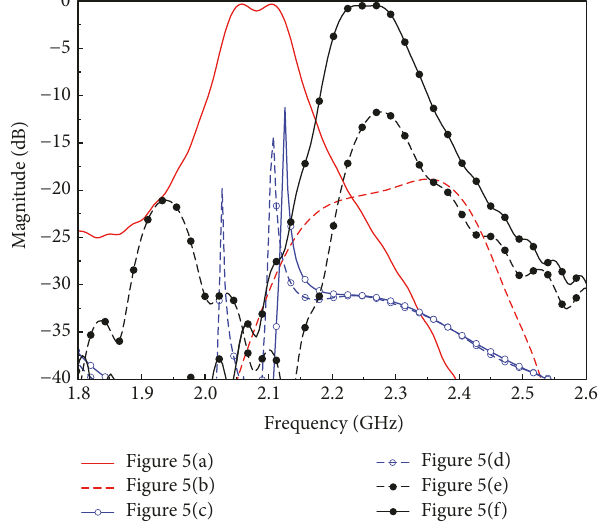
Figure 6: Simulated transmission coefficient ( S 11) with respect to the different orientation of two